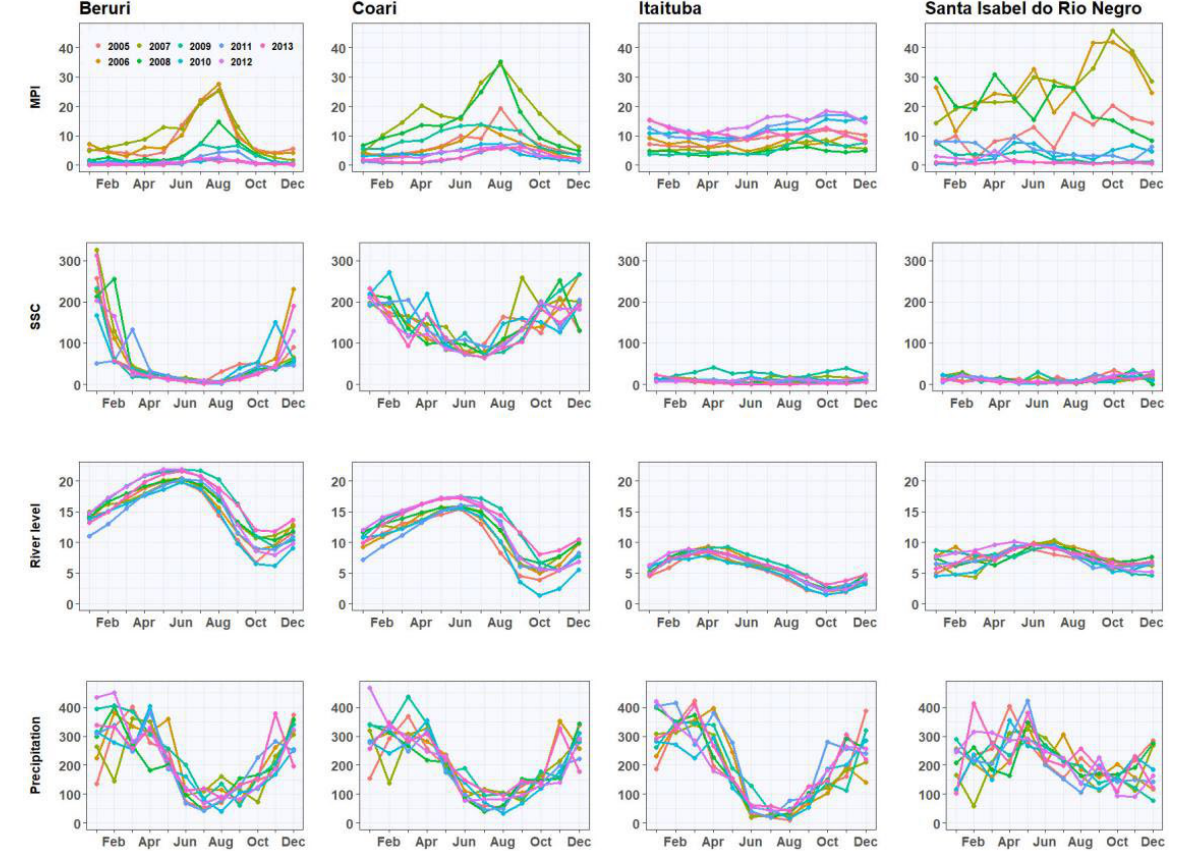
Figure 2. Time series (2005 to 2013) of monthly parasitic malaria incidence (MPI), suspended sedi- ments concentration (SSC), river level, and precipitation for the studied municipalities: Beruri, Coari, Santa Isabel do Rio Negro, and Itaituba.